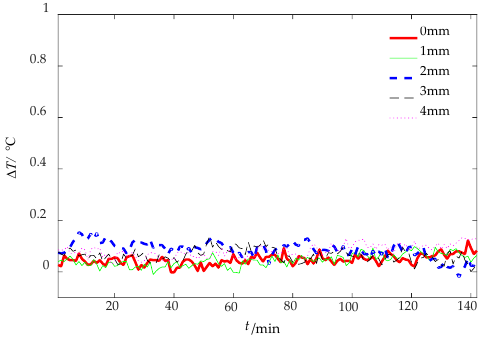
Figure 14. The thermal image of 30 min of sunshine excitation.